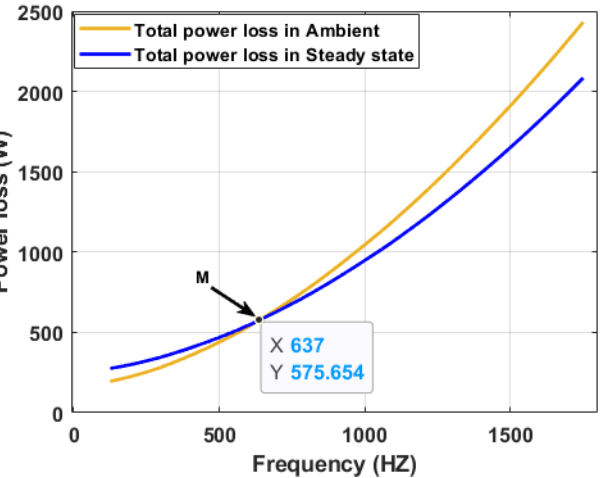
Figure 8. DC and AC losses versus frequency at the steady-state temperature.